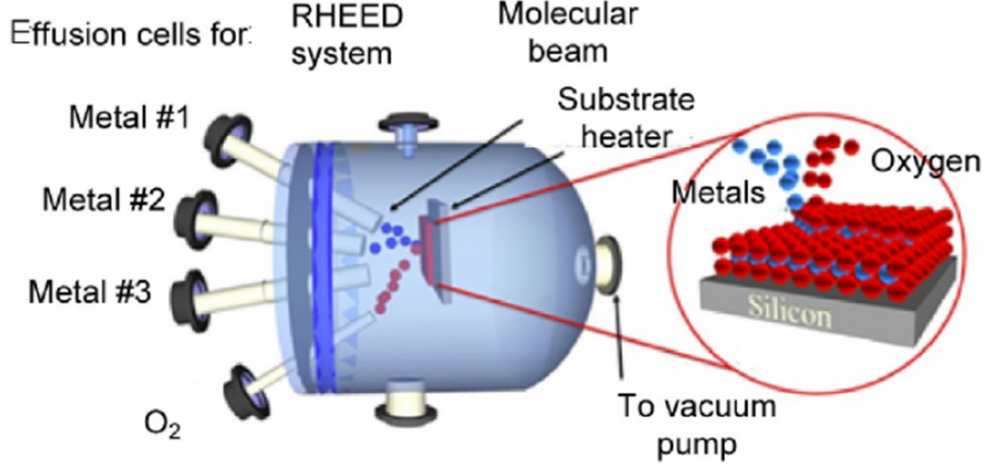
Figure 6. Schematic of MBE technique. Reprinted with permission from